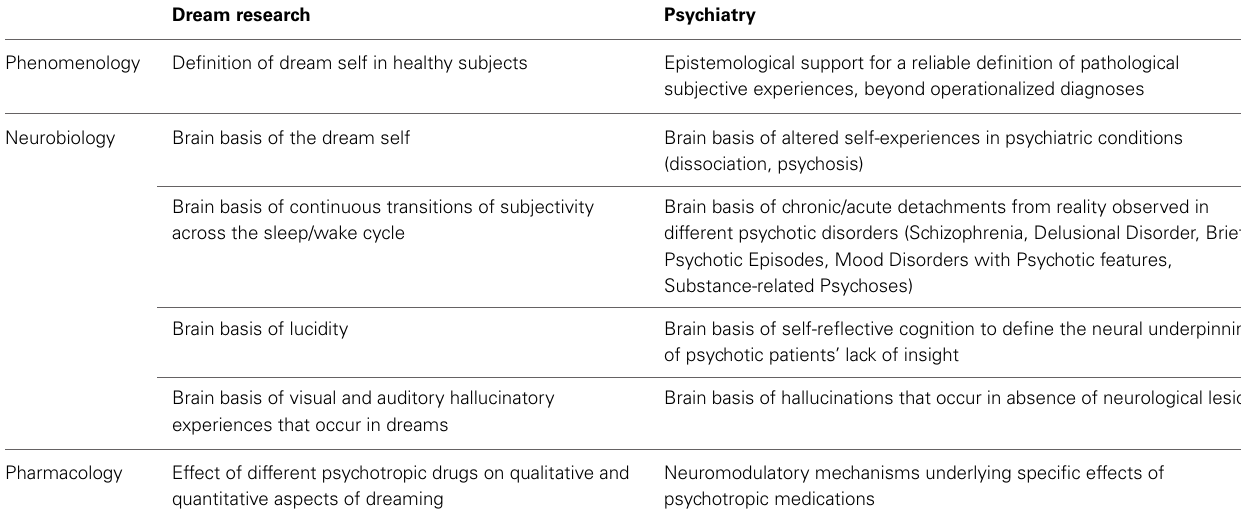
Table 2 | Implications of dream research for